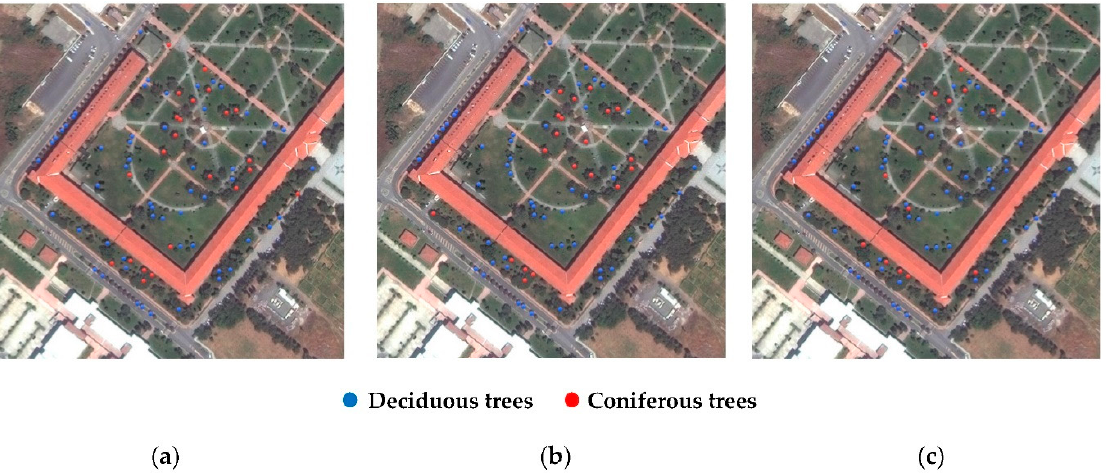
Figure 7. Training and test samples in the study area: ( a ) training sample set; ( b ) test sample set.